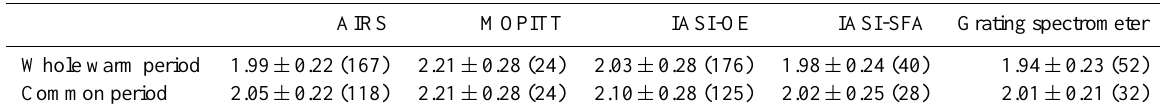
Table 2. Averages, STD of daily means, and numbers of days for CO TC ( × 10 18 moleccm − 2 ) for the 1 ◦ × 1 ◦ degrees grid cell centered at 55.5 ◦ N, 36.5 ◦ E for different data sets for 2009, months May through September, and 2010, months May and June, inclusive. MOPITT data for August and September 2009 are lacking due to a calibration of the instrument. The bottom row is for the period that is common for all 5 data sets.